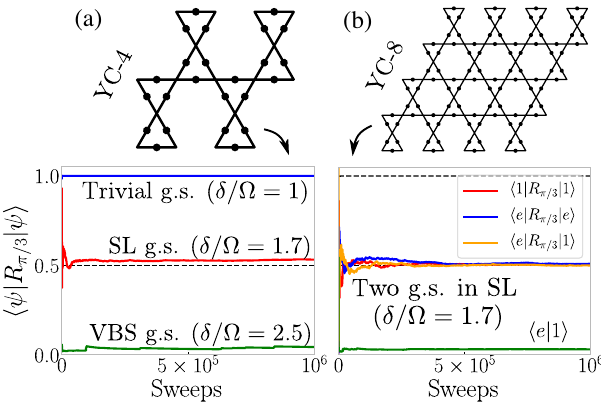
FIG. 7. Ground states and modular transformations. From the ground states on the infinitely long cylinder, we can obtain minimally entangled ground states on the torus geometry. For the smaller geometry, we show that, while the π = 3 rotation acts trivially on the trivial ( δ = Ω ¼ 1 ) or symmetry-breaking ( δ = Ω ¼ 2 . 5 ) phases, it leads to a nontrivial overlap in the spin liquid ( δ = Ω ¼ 1 . 7 ). We confirm for the larger torus (96 sites) that the overlaps for distinct ground states agree with the prediction (3) based on the modular transformation of a Z 2 spin liquid. The overlaps are shown as a function of the Monte Carlo sweeps, converging toward the value of approximately